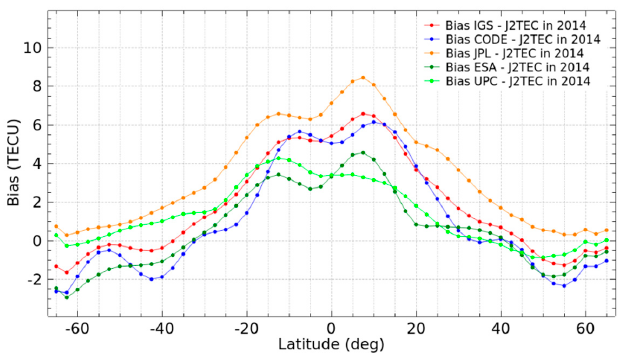
Figure 13. Bias values for comparison between IGS GIMs or IAAC products and J2TEC in 2014.